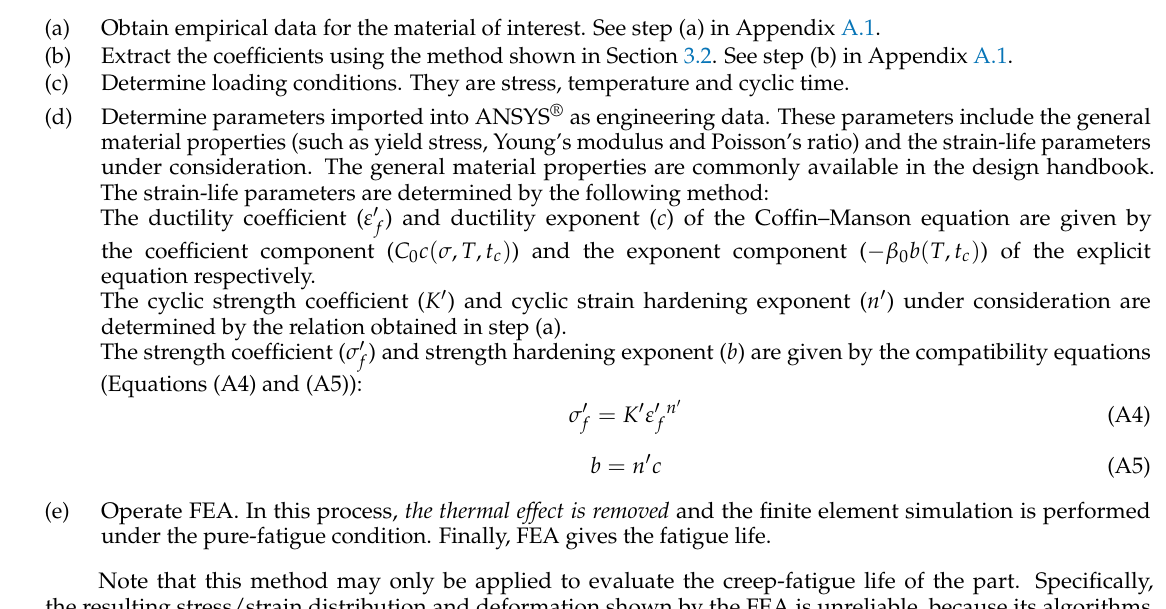
Figure A3. Fatigue life obtained at the pure-fatigue condition using explicit method. This example is also summarised in Table A1. Table A1. Fatigue evaluation by FEA. Simulation Using Conventional FEA Methods